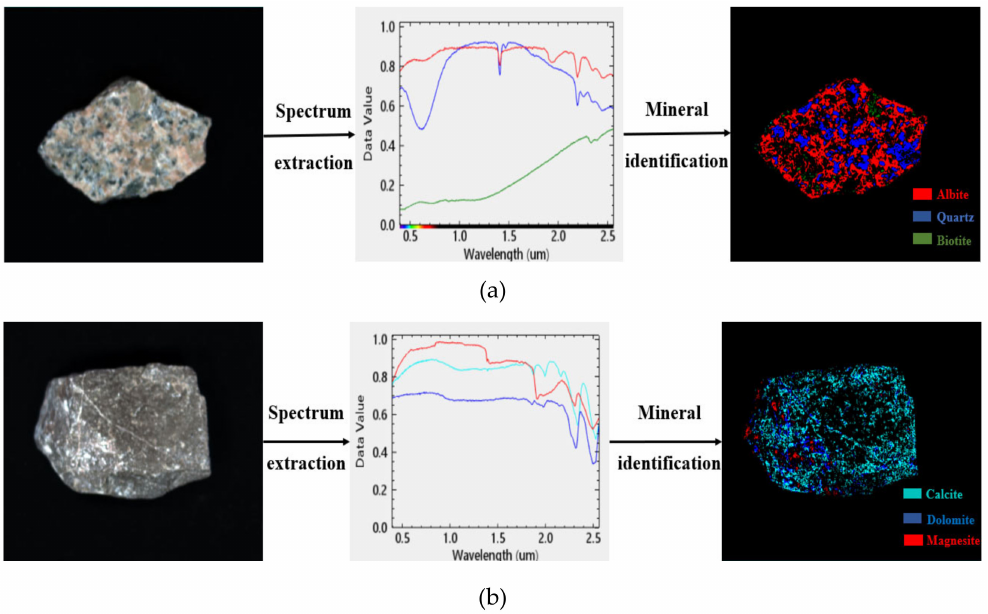
Figure 9. Hyperspectral identification of mineral components. ( a ) Mineral surface compositions of granite, ( b ) mineral surface compositions of